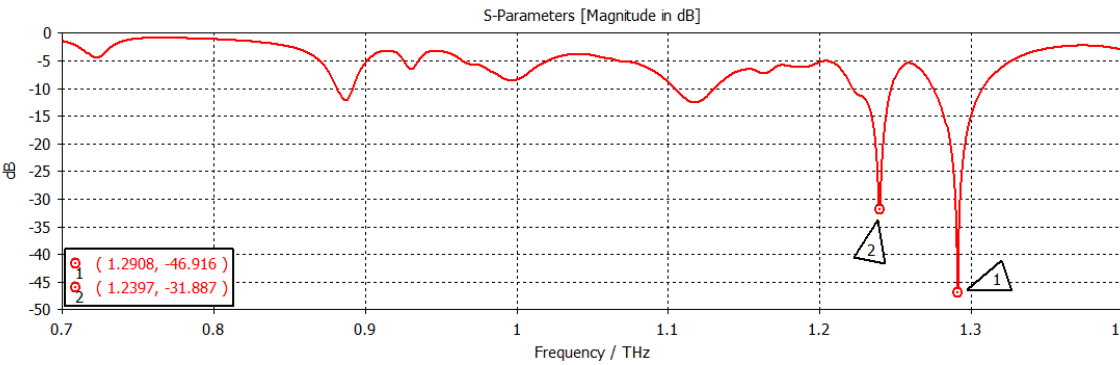
Figure 11. w 1 = 50 µm and z 1 = 100 µm.